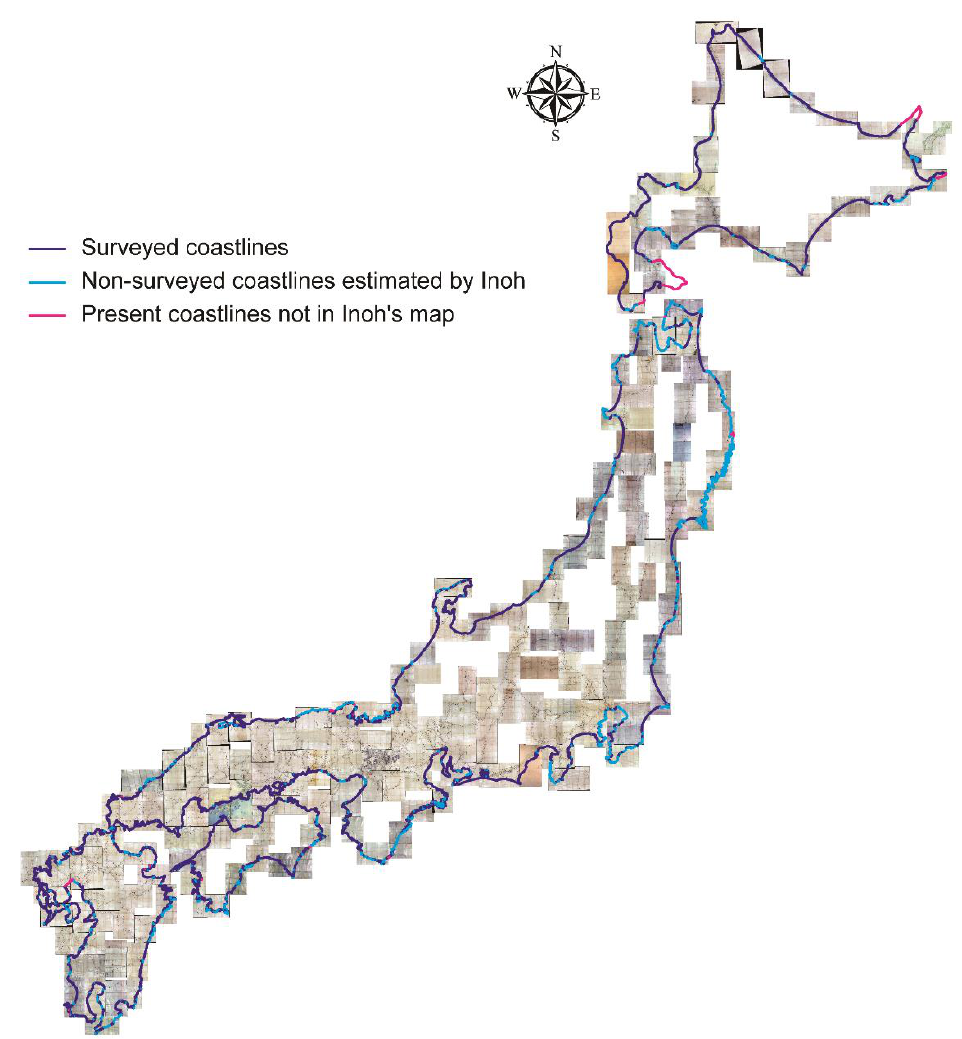
Figure 2. Coastlines in Inoh’s large-scale maps (1821). Only major islands of the Japanese archipelago (Hokkaido, Honshu, Shikoku, and Kyushu) are displayed. The image is superimposed on the georeferenced Inoh’s large-scale map. Source: Digital Inoh’s Map.